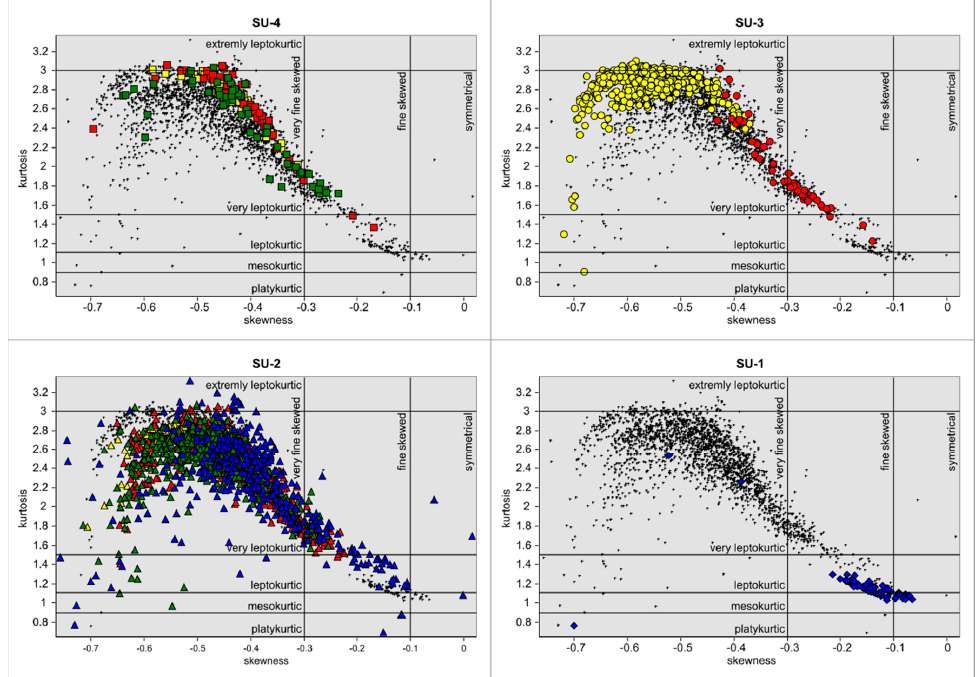
Figure 10. The bivariate plots show the relation between the skewness and the kurtosis for the four seismic units (SU). The colors represent the coring station (1: yellow, 2: red, 3: green, 4: blue). Black dots represent the complete data set (all SU).